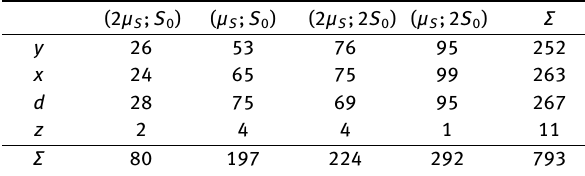
Table 5. SSO simulations: magnetic rotation (including magnetic tumbling) for different sets of simulation